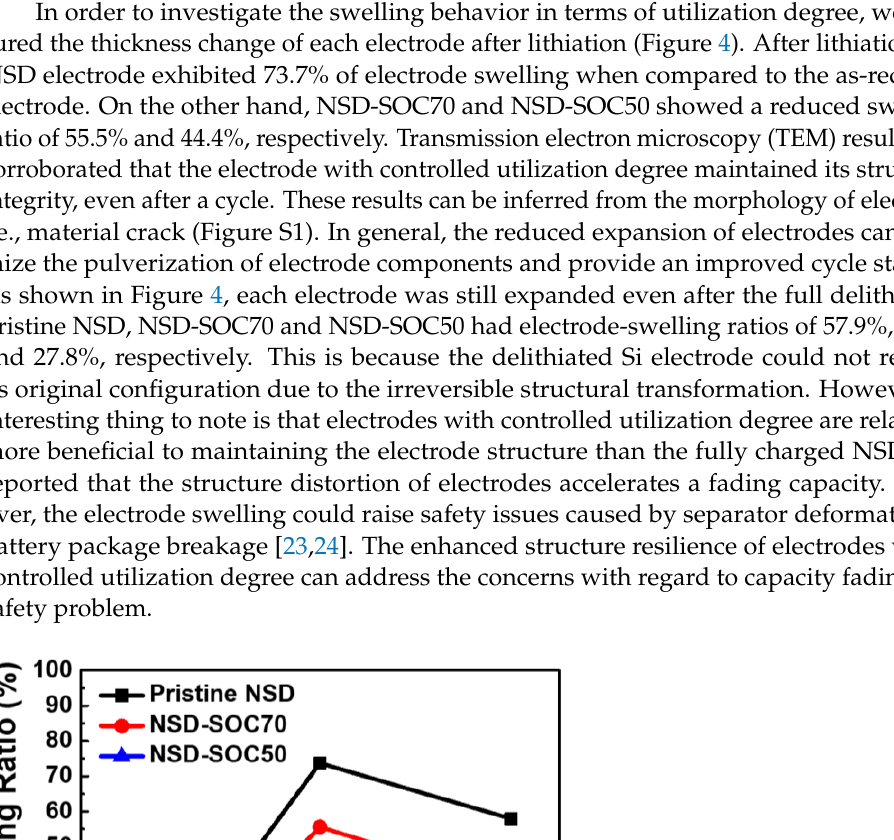
Figure 3. Electrochemical impedance spectra (EIS) of NSD electrodes before ( a ) and after cycling ( b ).